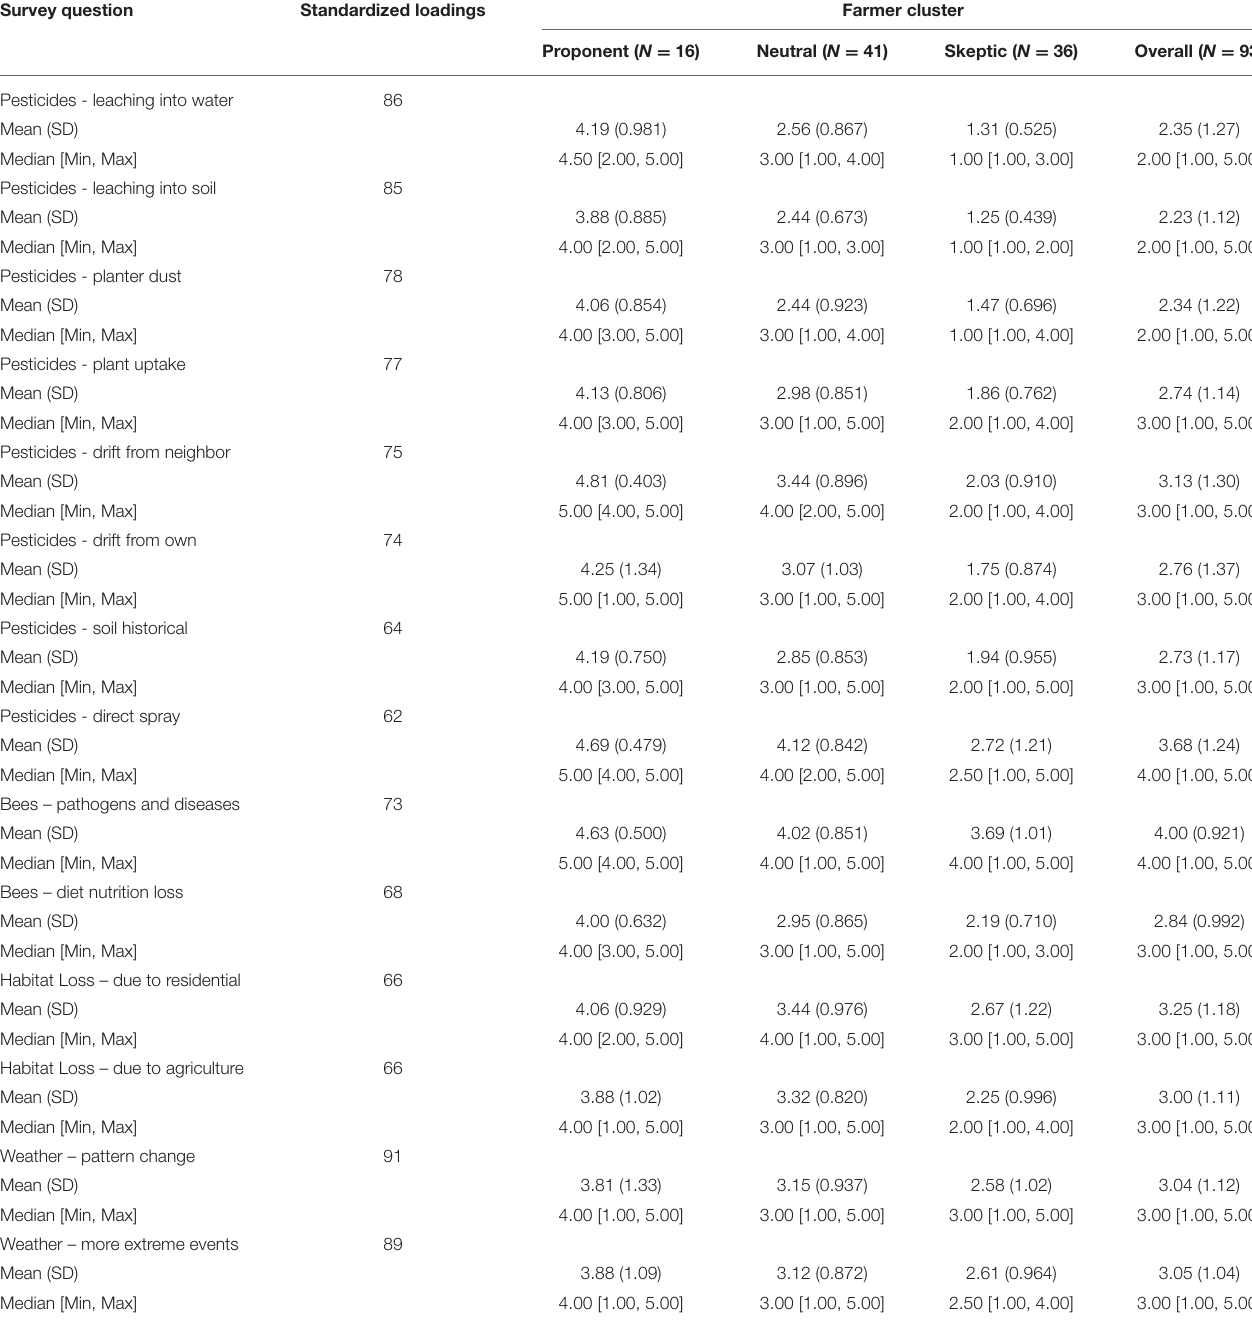
TABLE 2 | Farmer classes based on views of factors contributing to declines in pollinator health and the routes of pesticide exposure for pollinators on their farms. Survey